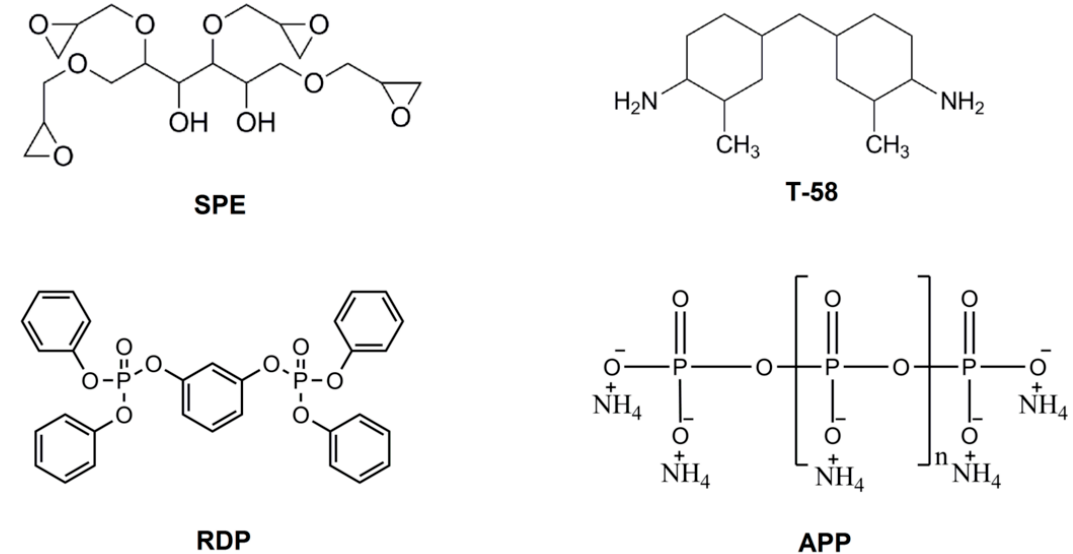
Figure 1. Chemical structures of the applied components.